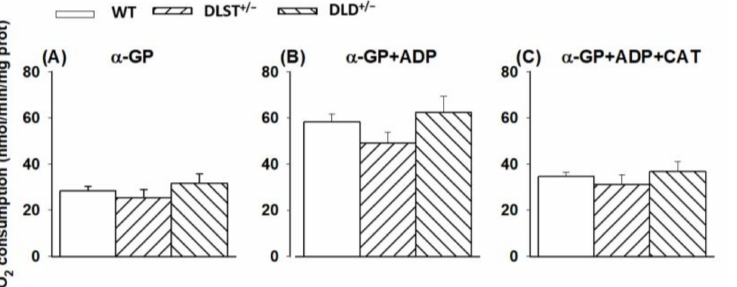
Figure 3. Oxygen consumption of mitochondria isolated from wild-type and KGDHc subunit heterozygote KO mice respiring on α -glycerophosphate in the absence ( A ) or presence ( B , C ) of ADP, and after the addition of carboxyatractyloside (CAT), ( C ). α -GP (20 mM), ADP (2 mM); ( B , C ) and CAT (2 µ M); ( C ) were given as indicated. All other conditions and representations are as in Figure